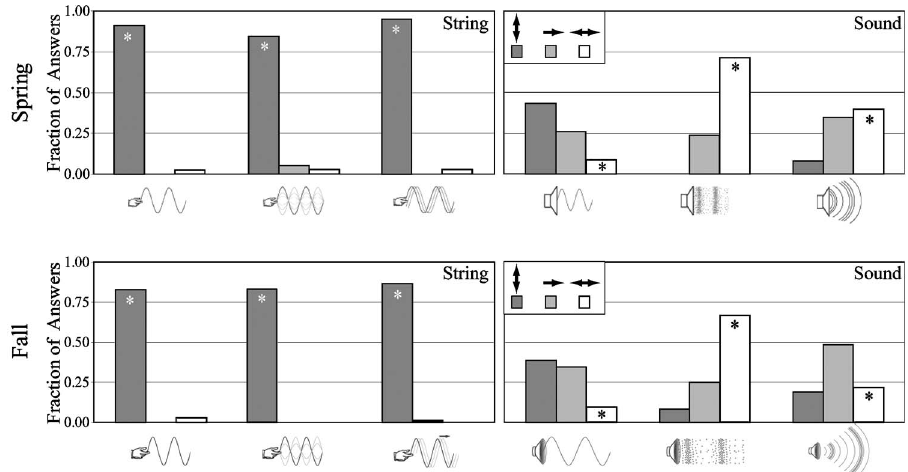
FIG. 6. Student responses to the motion question on the representation assessment. String group (cid:1) left (cid:2) and sound group (cid:1) right (cid:2) . Initial study results (cid:1) spring (cid:2) are shown in the top two graphs; follow-up study results (cid:1) fall (cid:2) are shown in the bottom graphs. The choice of iconographic representation is shown below the horizontal axis. The three top answers (cid:1) up/down, to the right, side-to-side (cid:2) are represented by the directional arrows in the legend. We look for patterns of association between representation and answer. There was no association for string (cid:1) (cid:4) 2 : p (cid:1) 0.3 (cid:2) , but significant association for sound (cid:1) (cid:4) 2 : p (cid:2) 0.01 (cid:2) . The “ (cid:1) ” indicates the correct